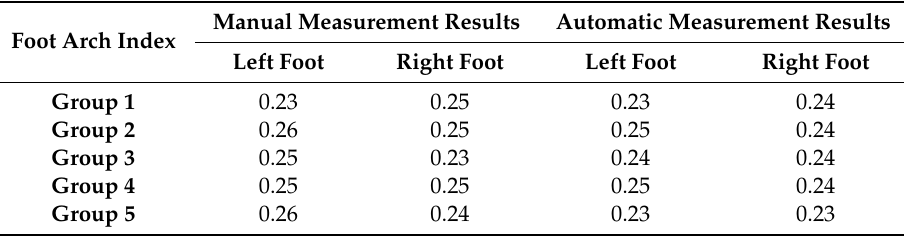
Table 2. Results of the two measurement methods for the normal